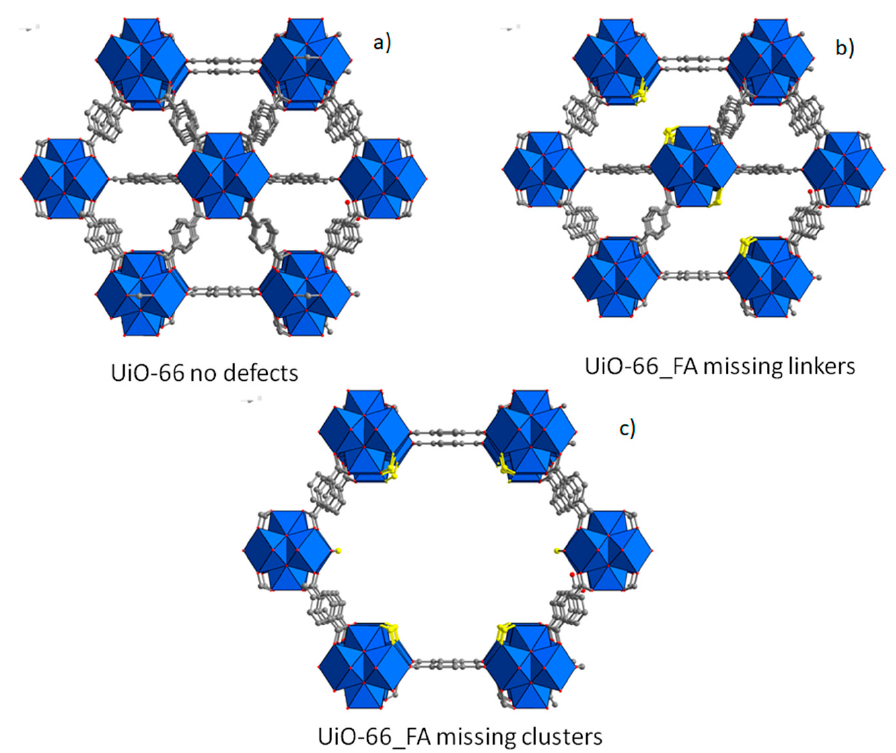
Figure 2. Structure of non-defective ( a ), missing linker defective ( b ), and missing cluster defective ( c ) UIO-66 phase. Formic acid is evidenced in yellow. Zirconium clusters are depicted in blue.